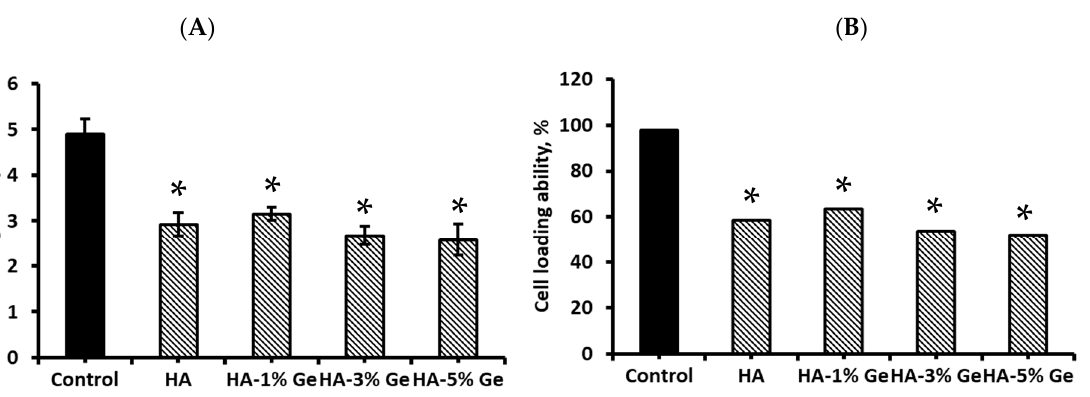
Figure 12. The total BM-MSCs seeding capacity of HA-Ge biomaterials. ( A ) and ( B ) are the actual and percentage of cell seeding density of BM-MSCs on HA-Ge composites, respectively. Control— BM-MSCs cultured without HA or HA-Ge composites, HA—HA without Ge, HA-1%Ge—HA with 1% germanium, HA-3%Ge—HA with 3% germanium, and HA-5%Ge—HA with 5% germanium. * denotes statistical significance, p < 0.05 vs. control.